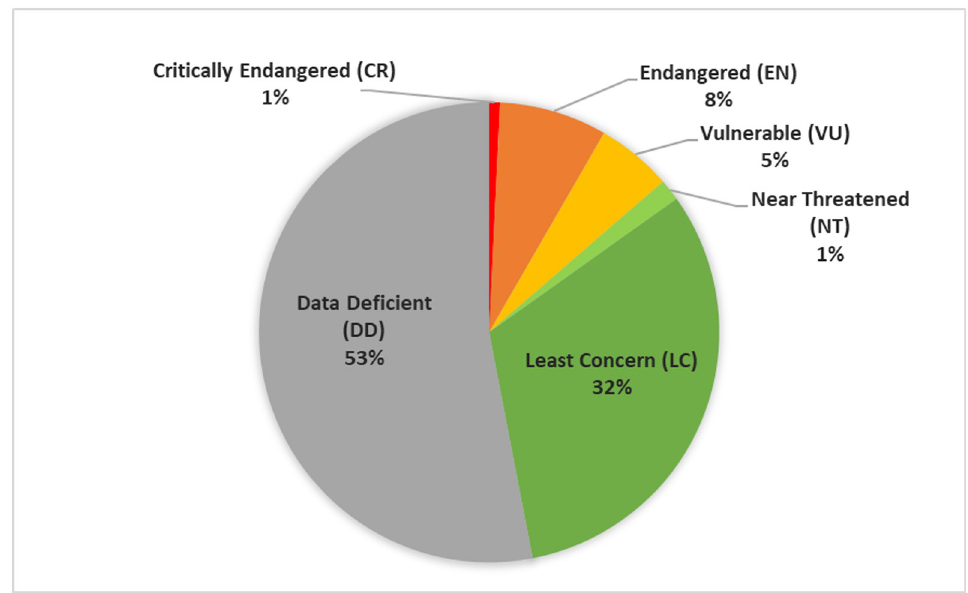
Fig 1. IUCN Red List categories for 132 North American firefly species.